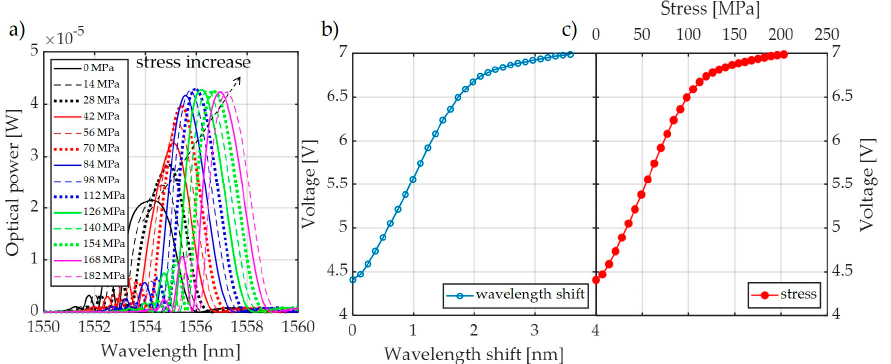
Figure 16. Measurement results using the interrogator presented in Figure 3b for the FBG + FBGF3 matched gratings pair: ( a ) change in the shape of the system output signal; ( b ) wavelength shift processing characteristics; ( c ) characteristics of the power line conductor stress conversion to changes in the voltage on the photodetector. Sensors 2020 , 20 , x FOR PEER REVIEW